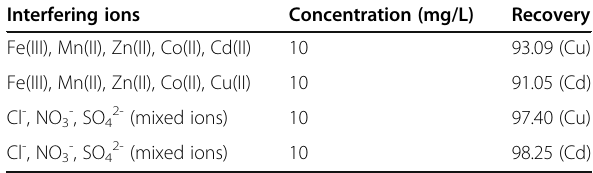
Table 6 The effect of interfering ions on